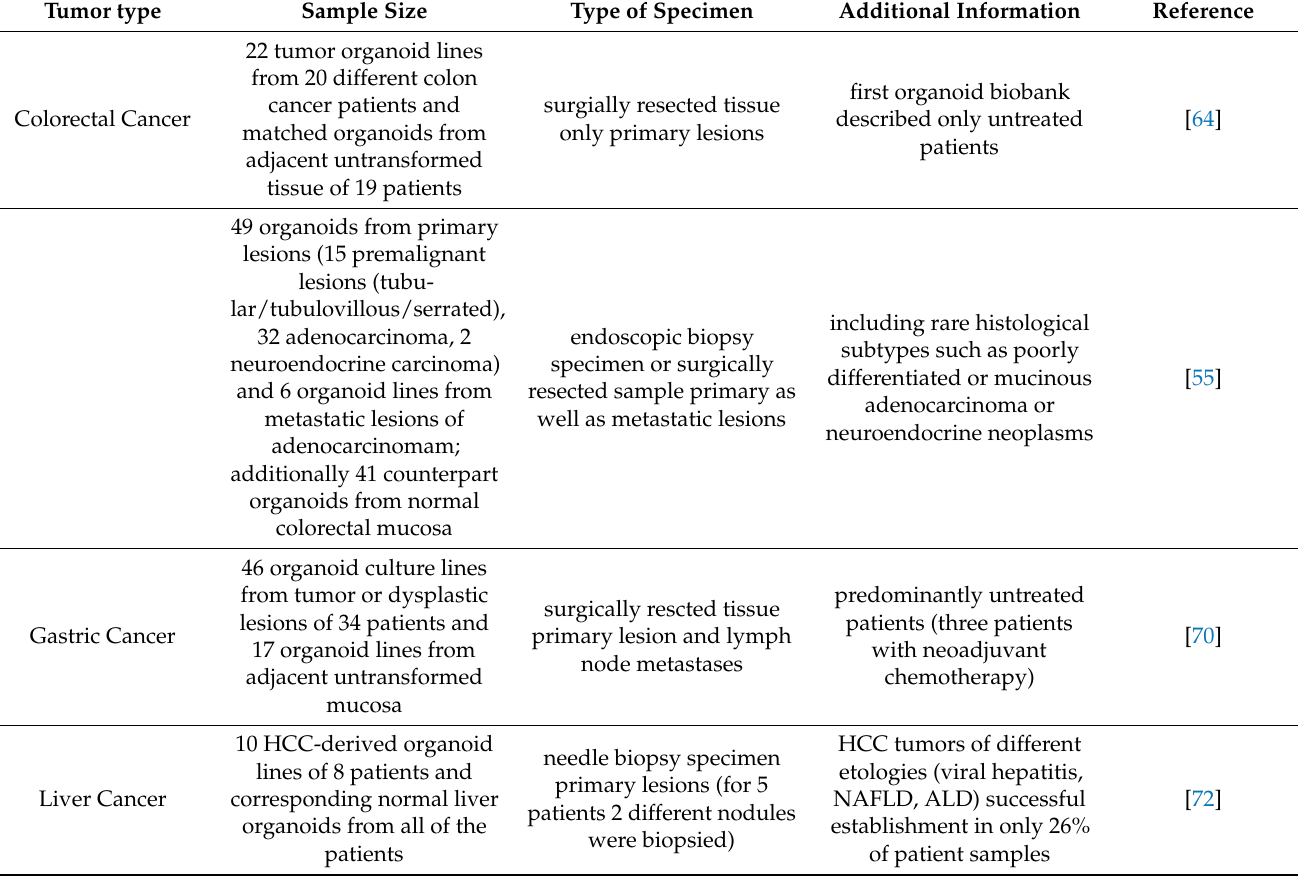
Table 1. Exemplary summary of published PDO biobanks of different tumor